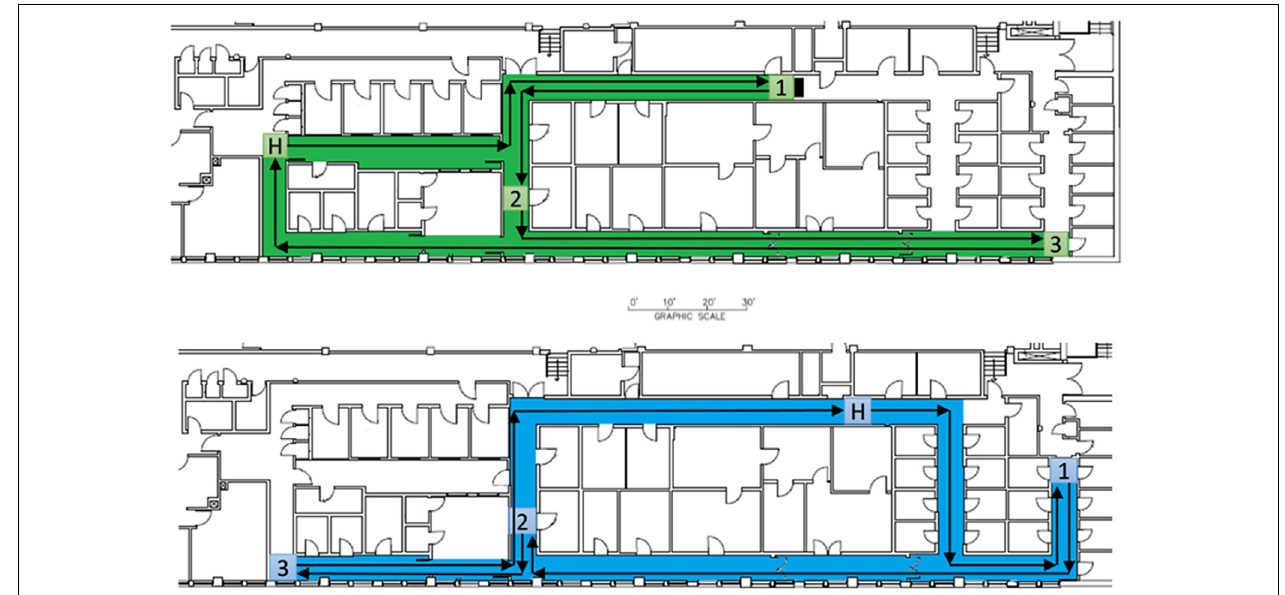
FIGURE 1 | Building floorplan and maps for the two experimental conditions. The highlighted region of the floorplan was selected for the map. The four, square regions in each map represent the three objects and home locations of the maps. The arrows illustrate an example of optimal route efficiency for successful wayfinding (start and end at H).